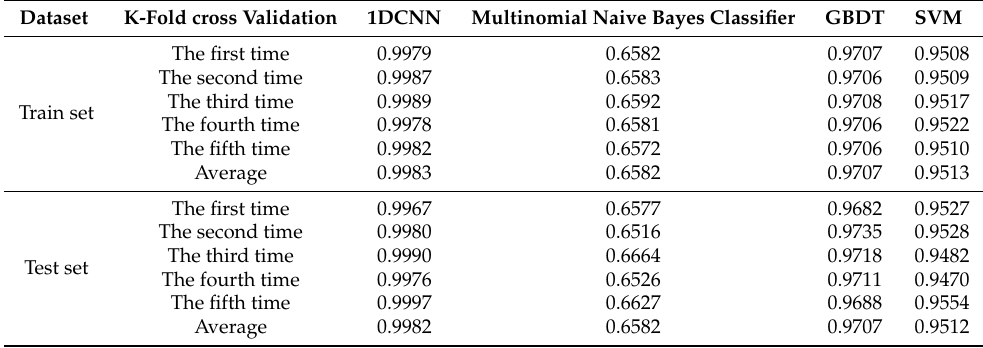
Table 5. Comparison of evaluation results.